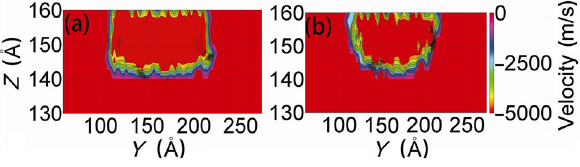
Fig. 8 The velocity distribution of the water in the z-axis direction when the jet first contacts with the substrate. (a) Pos20 at 750 fs; (b) Pos150 at 3,750 fs.